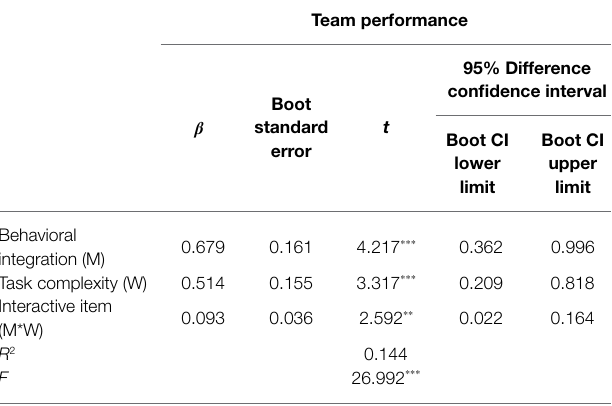
TABLE 4 | Moderating effect test of task